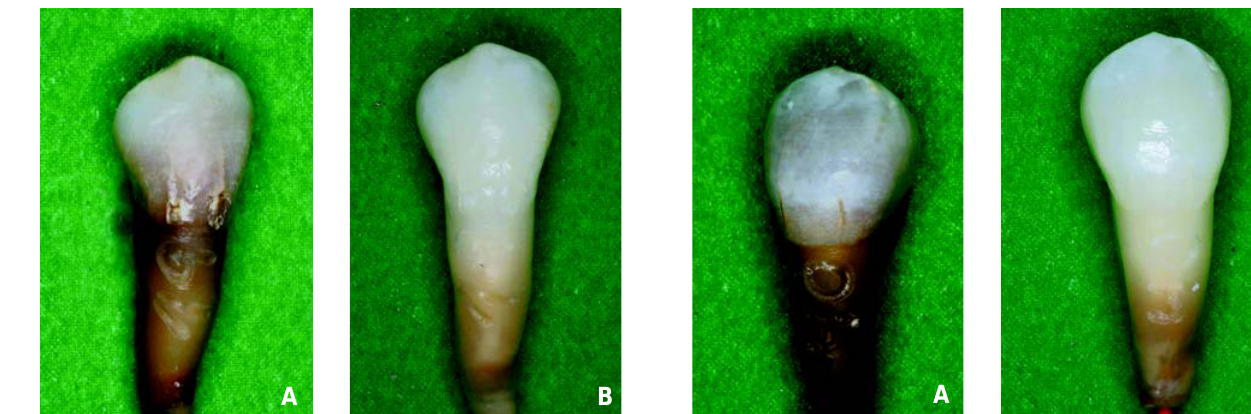
FIGURE 3- Specimen representative of group G2 after discoloration (A) and after 21 days of bleaching (B) with the mixture of 16% carbamide peroxide gel + tetrahydrate sodium perborate